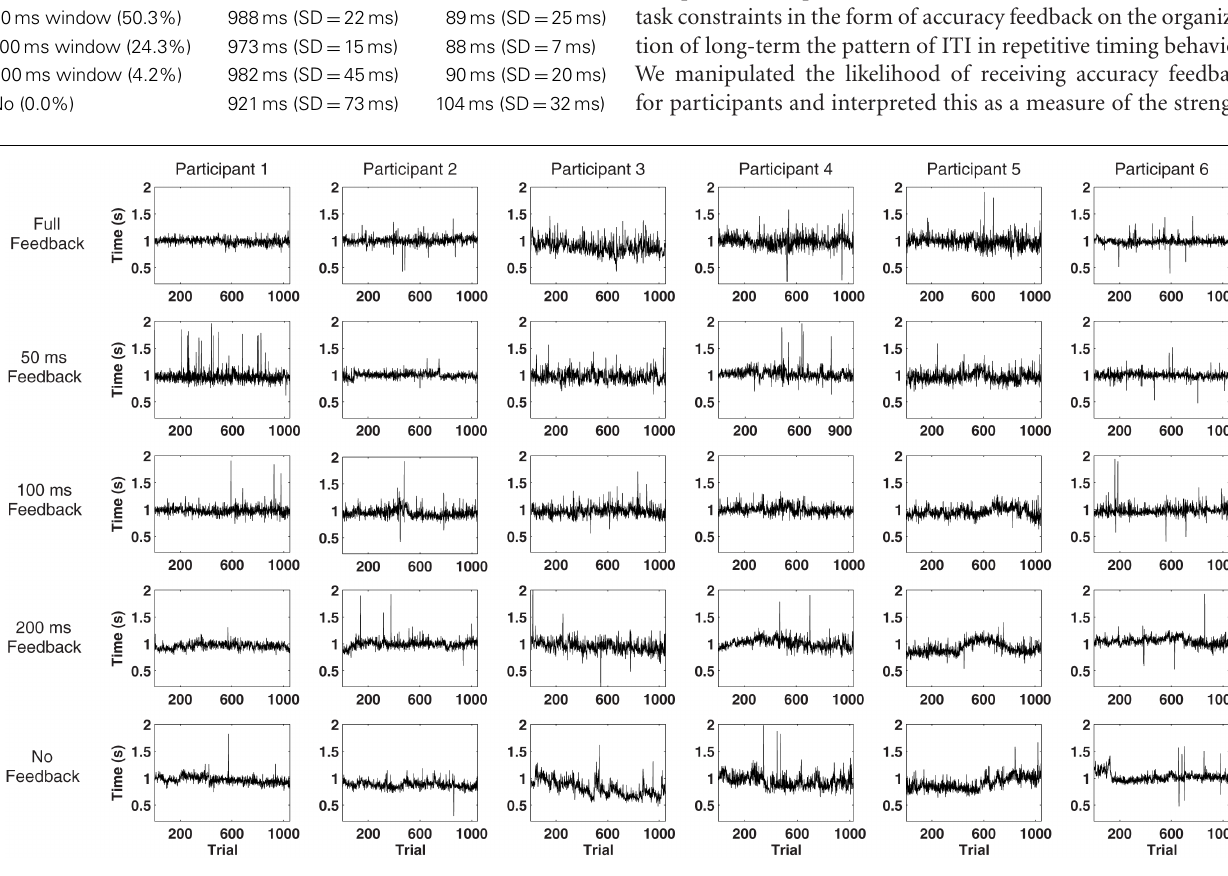
FIGURE 2 | Illustration of the individual response series in each one of the experimental